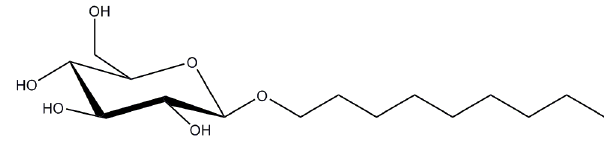
Figure 6. Structure of Nonyl glucoside (NG) (chemical formula is C 15 H 30 O 6 ).